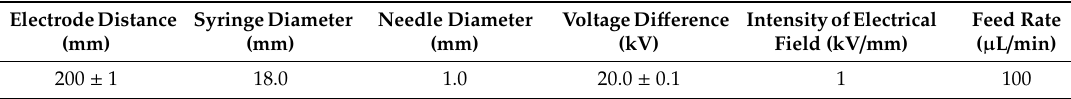
Table 1. Set up conditions used for electrospinning of PHB